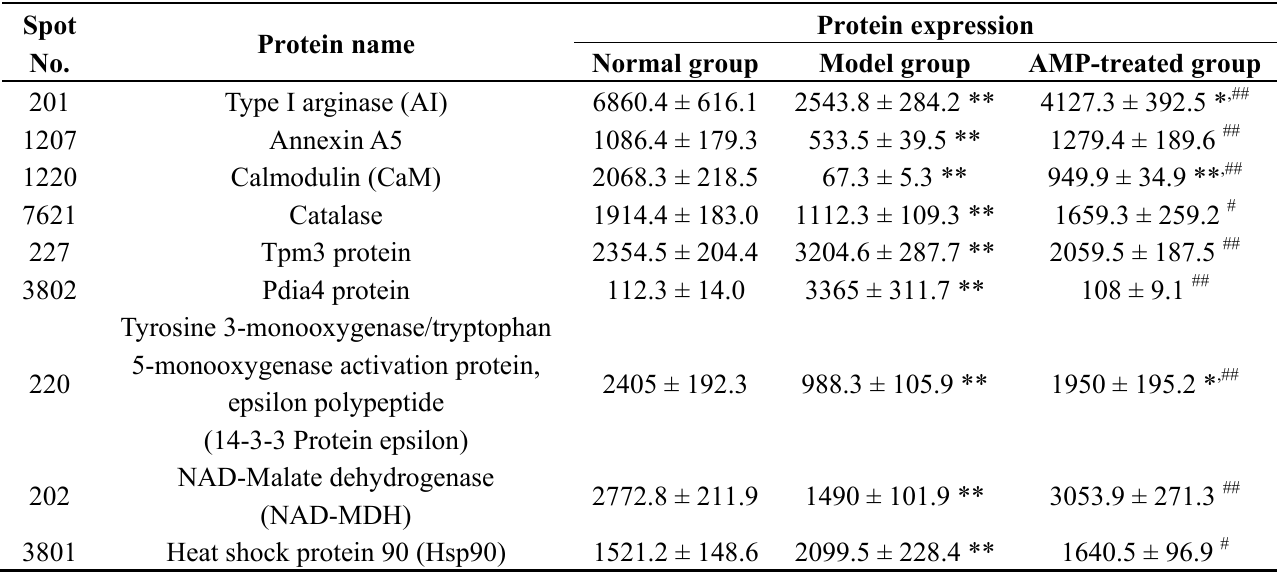
Table 1. Expression and identification of the selected proteins in three groups.